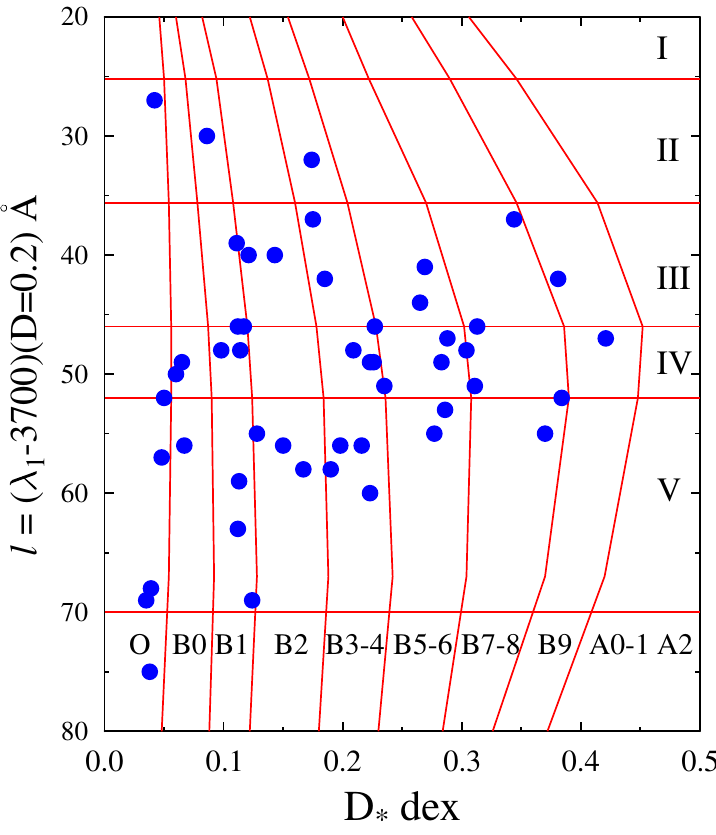
Figure 4. BCD spectral classification diagram for Be stars in terms of luminosity class parameter l against the photospheric BD, D ∗ . This is one of the first HR-type diagrams showing that the Be phenomenon can appear at whatever evolutionary phase because ( l , D ∗ ) characterizes the stellar photosphere of the central star